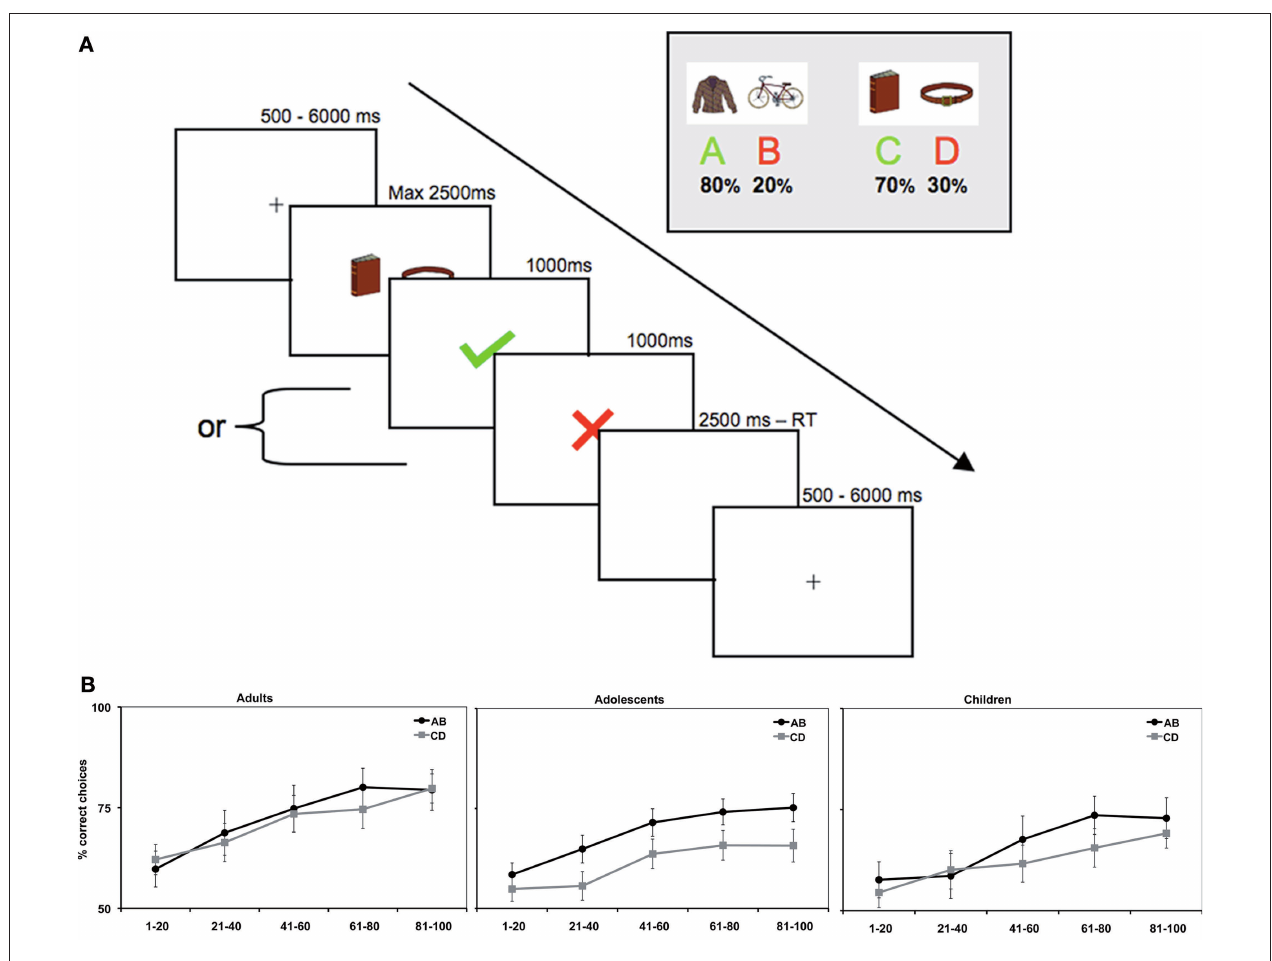
filler was presented, in the form of a blank screen, in order to compensate for different reaction times between trials and between participants (filler duration = 2500 ms – reaction time). (B) Average accuracy on AB and CD trials per age